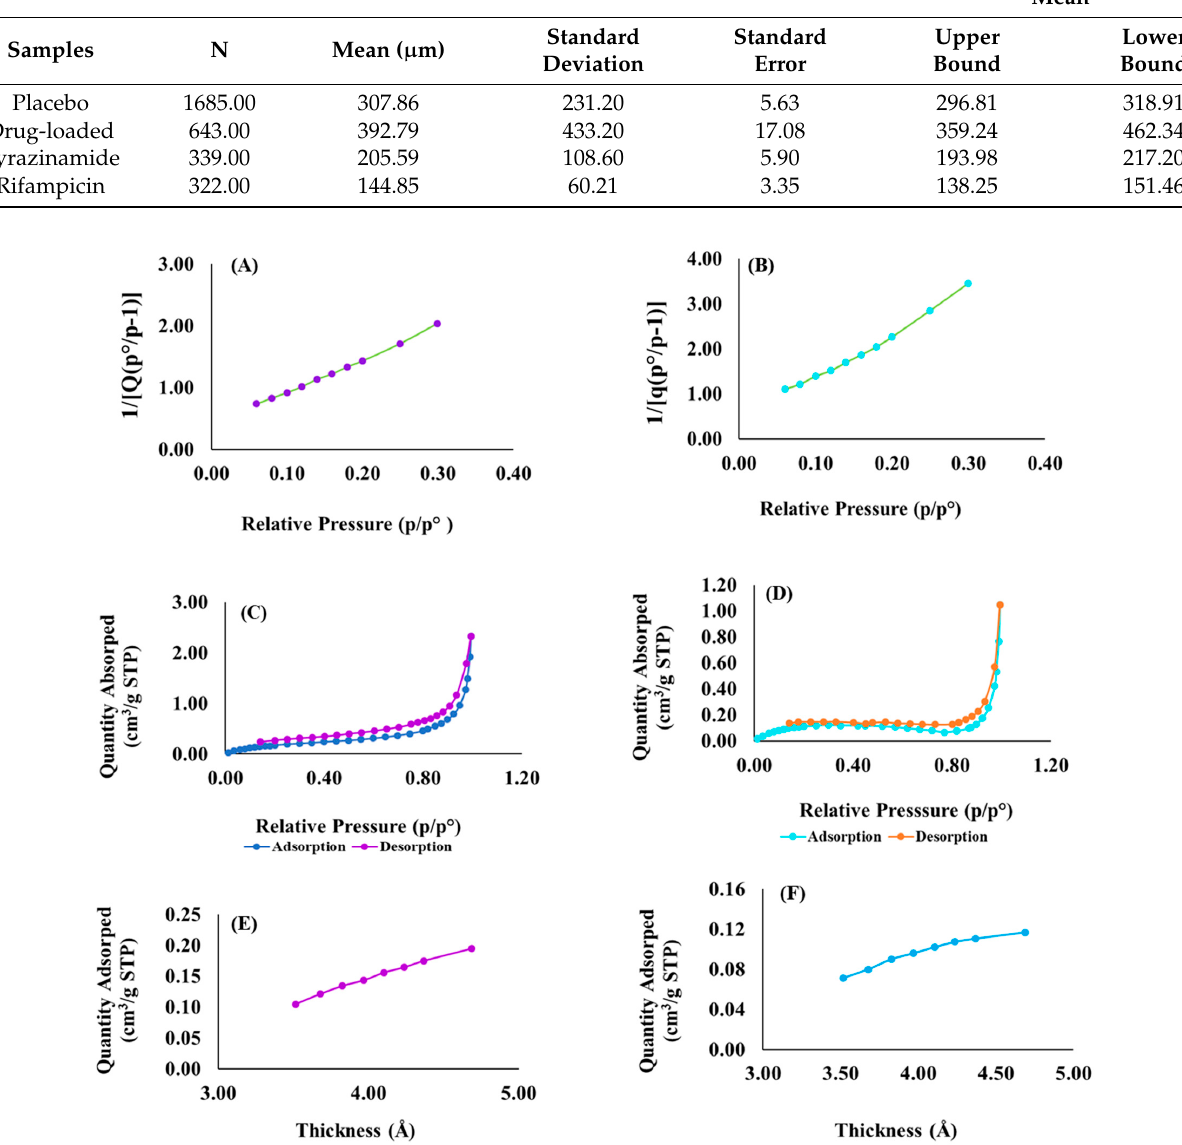
Figure 8. Surface area of ( A ) placebo and ( B ) drug-loaded formulation; isotherm curve displaying adsorption and desorption of ( C ) placebo and ( D ) drug-loaded formulation; thickness curve of ( E ) placebo and ( F ) drug-loaded formulation.